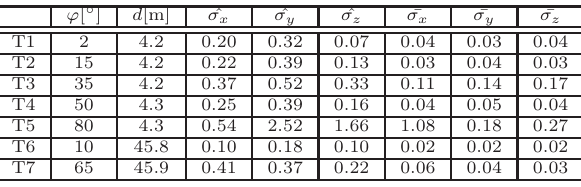
Table 3: Empirical and theoretical standard deviations For ν = 59 degrees of freedom and confidence level of 99 %, the confidence interval is [34 . 77 , 90 . 71]. The obtained test statistic for all coordinate components of all targets are in Table 4.